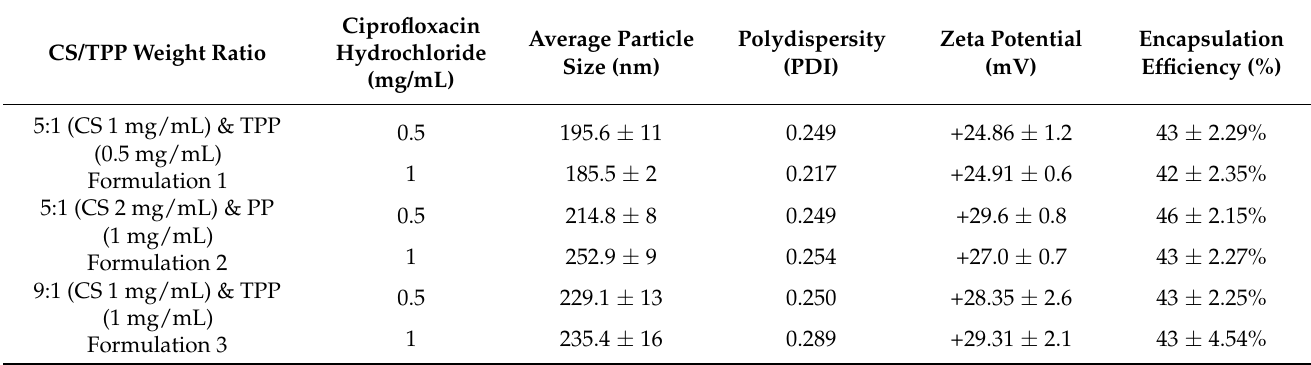
Table 1. Encapsulation Efficiency, Particle Size, Polydispersity Index, and Zeta Potential